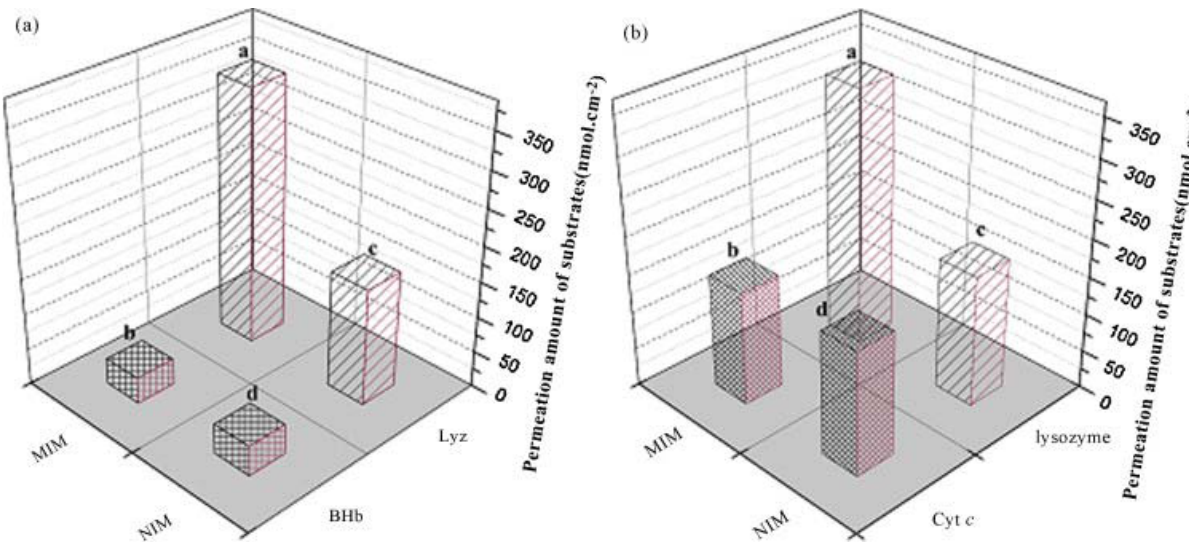
Figure 5. Selectivity activity of MIM and NMIM towards mixture containing lysozyme and BHb ( a ) and Cyt c ( b